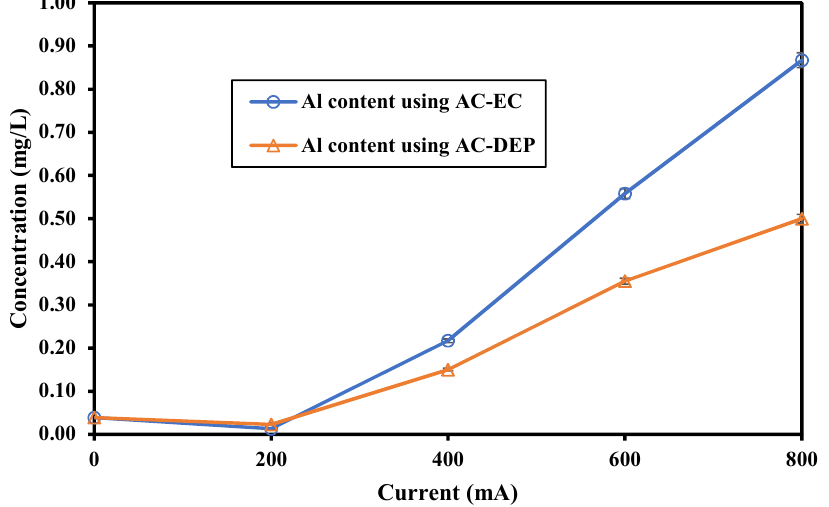
Figure 12. Aluminum content in the reactor using AC-EC and AC-DEP with 0.5 cm electrodes spacing and an operational time of 30 min.